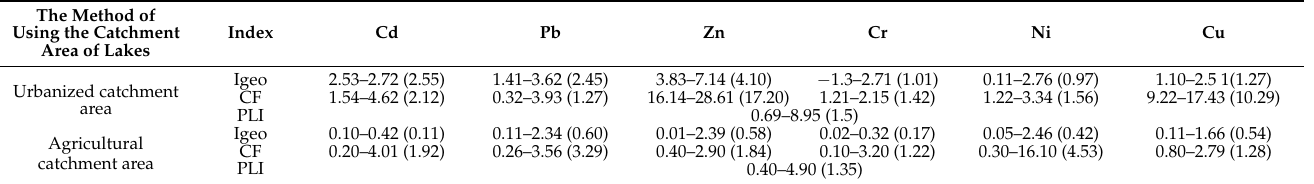
Table 11. Comparison of the indices of Igeo, PLI, and CF, which were determined for other lakes with similar and different land